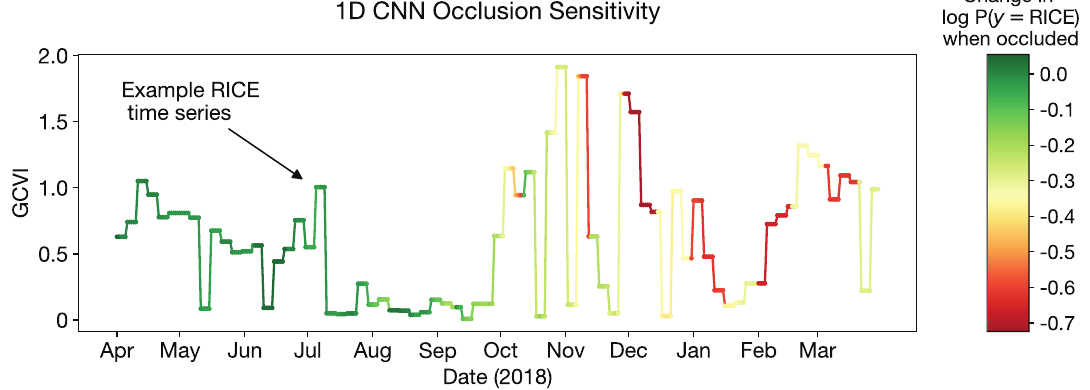
Figure A15. Occlusion sensitivity analysis. We blocked a 5-day sliding window of values in an example time series and analyzed its effect on the probability score output by the 1D CNN. The time series is originally correctly classified by the network as “rice”. The values substituted in the occlusion window are the mean of the time series. Only GCVI is visualized, but all Sentinel-2 and Sentinel-1 values in the window were occluded. Cloudy observations appear as low values in GCVI. The greater the decrease in log P ( y = RICE ) (more red), the more the 1D CNN relies on that segment of the time series for classification. Conversely, greener segments are less important for classification.